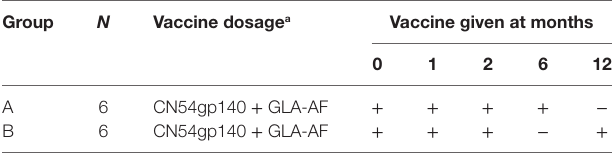
TaBle 1 | Vaccine dosage and study